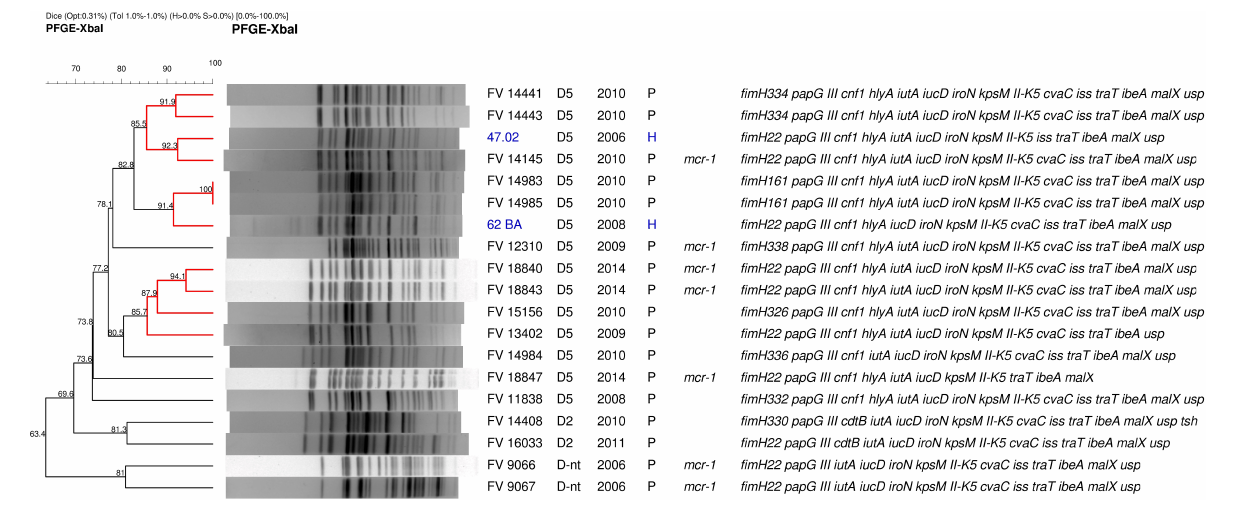
Frontiers in Microbiology |